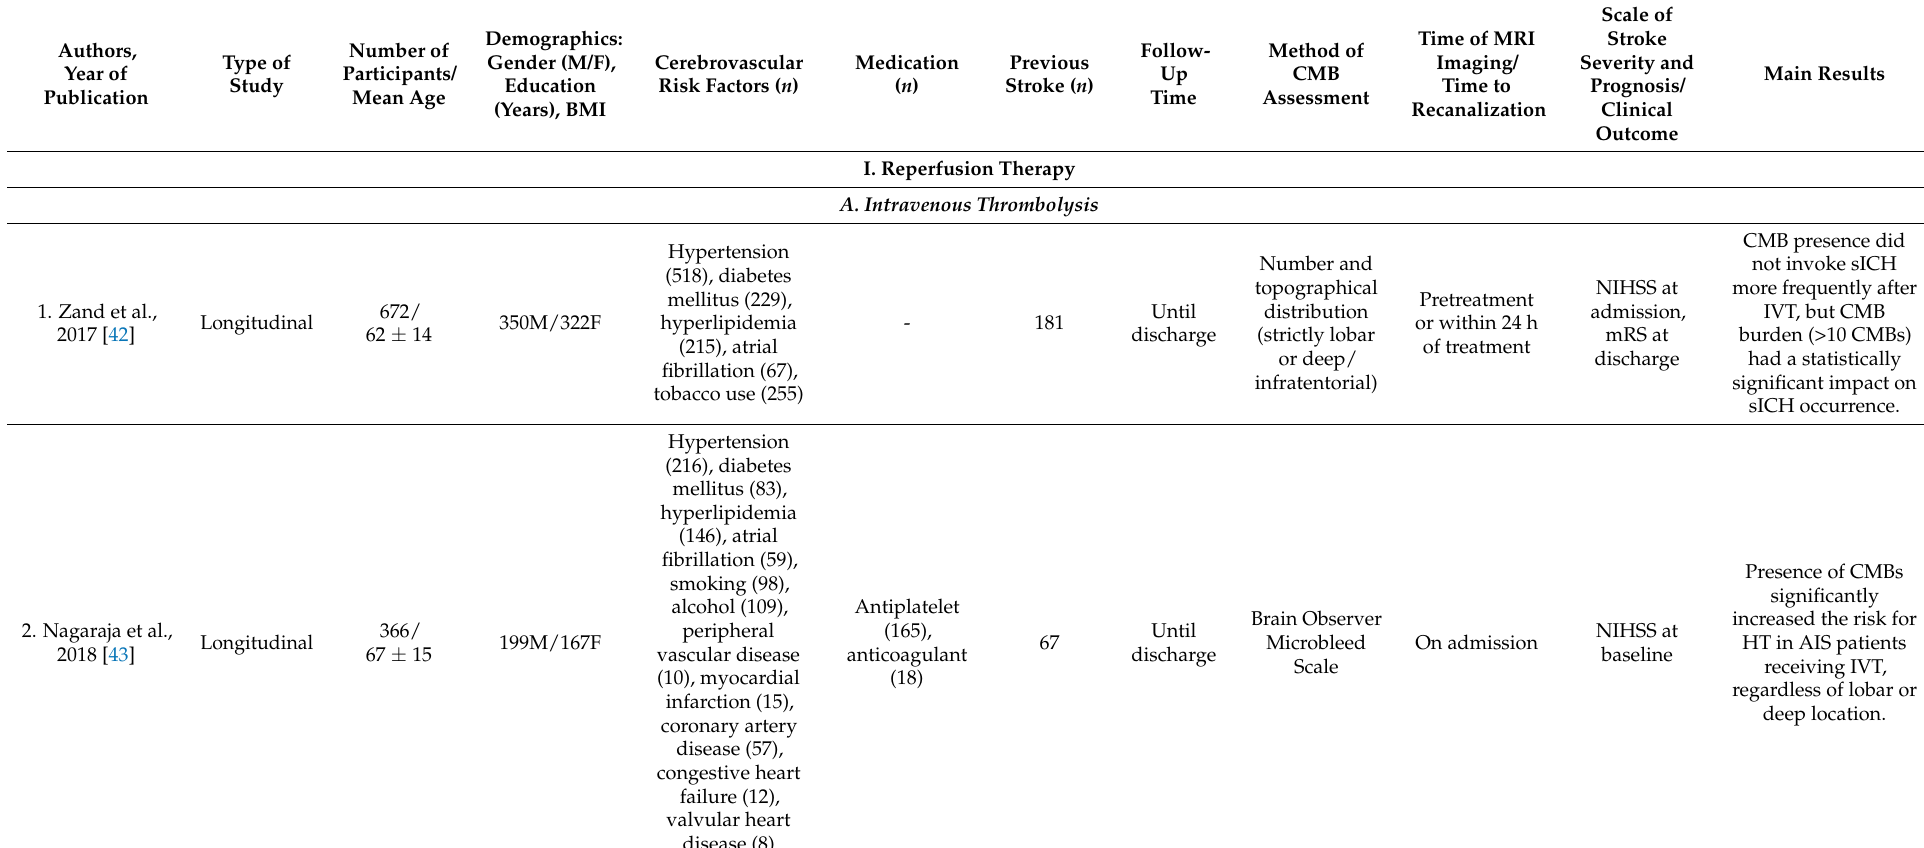
Table 1. Characteristics of the 41 included